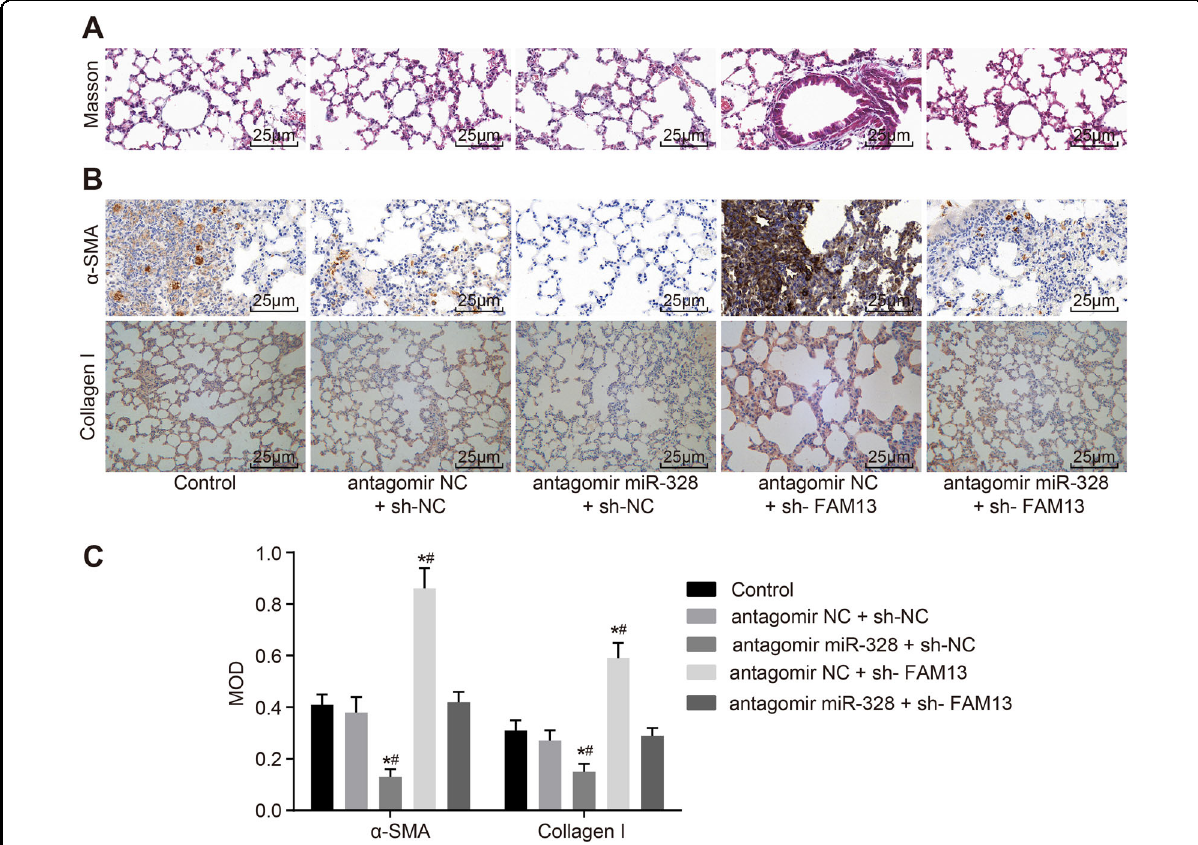
Fig. 7 miR-328 inhibition in M2 macrophages suppresses the progression of PF by targeting FAM13A . a Masson staining to examine the degree of PF in rats after the inhibition of miR-328 and FAM13A (400× ). b IHC to analyze the expression of α -SMA and Collagen I in rats after the inhibition of miR-328 and FAM13A (400× ). c MOD values of α -SMA and Collagen I in rats after the inhibition of miR-328 and FAM13A. miR-328, microRNA-328; PF, pulmonary fi brosis; FAM13A, family with sequence similarity 13, member A; α -SMA, α -smooth muscle actin; IHC, immunohistochemistry; and NC, negative control. * p < 0.05 vs . the control group; # p < 0.05 vs . the antagomir NC + sh-NC group. All results were measurement data and were analyzed using one-way analysis of variance. The results are expressed as the mean ± standard deviation; n =